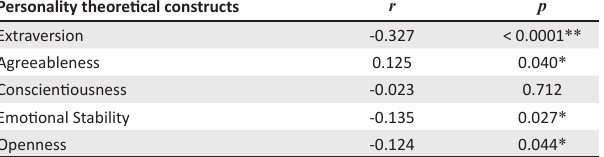
TABLE 4: Pearson product-moment correlations ( r ) and significance probabilities ( p ) for relations of behaviour-based conflict to personality theoretical constructs. Personality theoretical